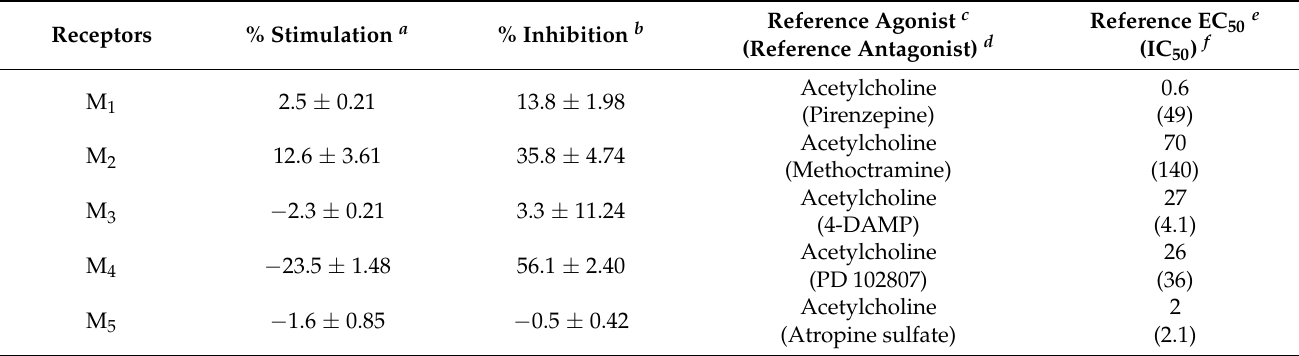
Table 3. Percentage stimulation and percentage inhibition of recombinant human muscarinic acetylcholine receptors by tanshinone